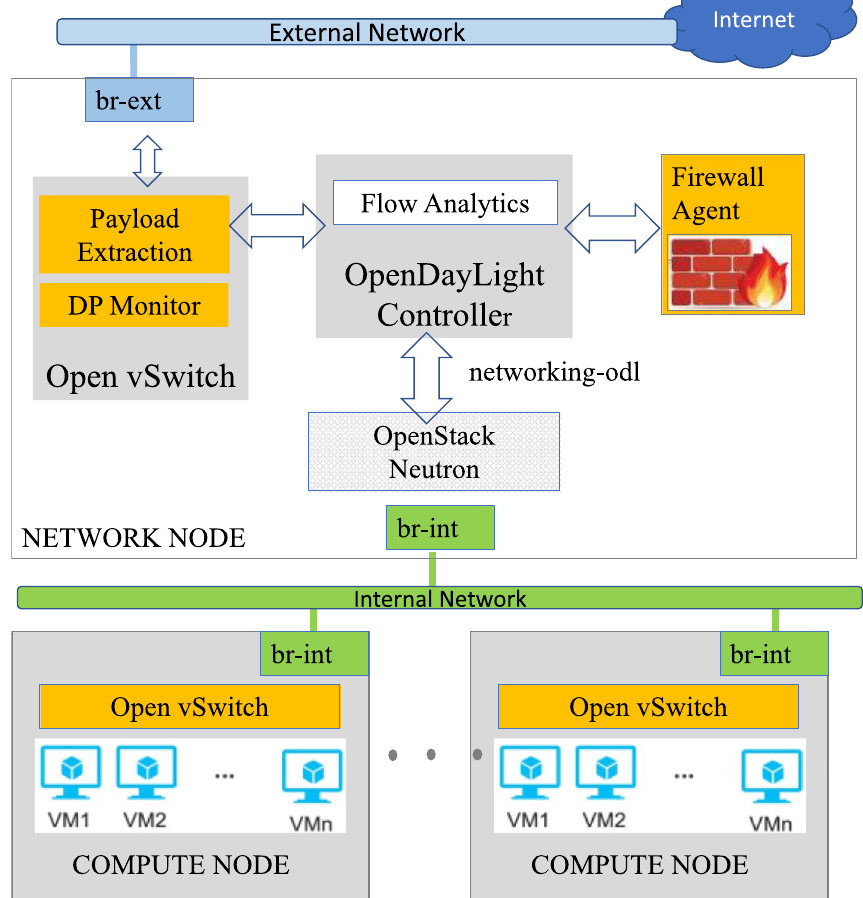
Fig. 7 Intelligent SDN-based Firewall in Network